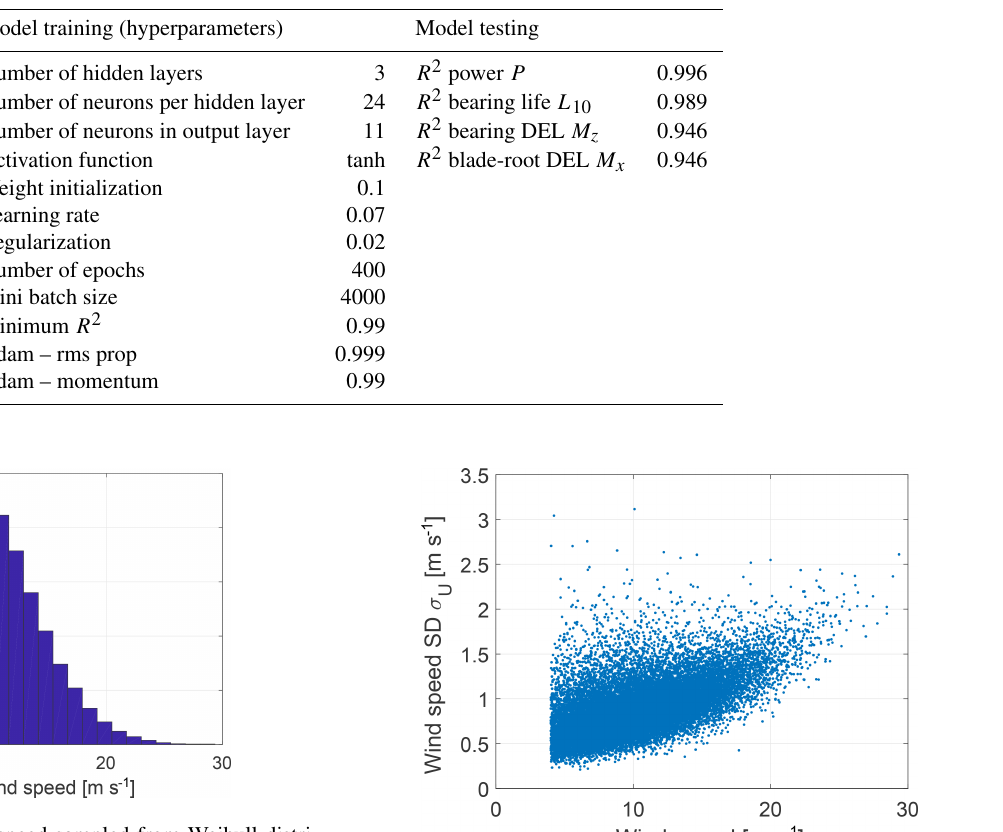
Figure 11. Site-specific wind speed sampled from Weibull distri- bution from free-stream SCADA data.